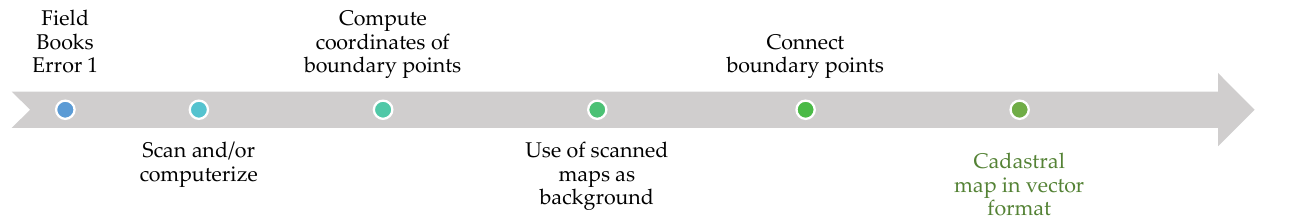
Figure 7. ( a ) The process of digitisation conducted in North Macedonia and Slovenia based on CTM; ( b ) Revised process of digitisation based on CTM by considering surveying field books.